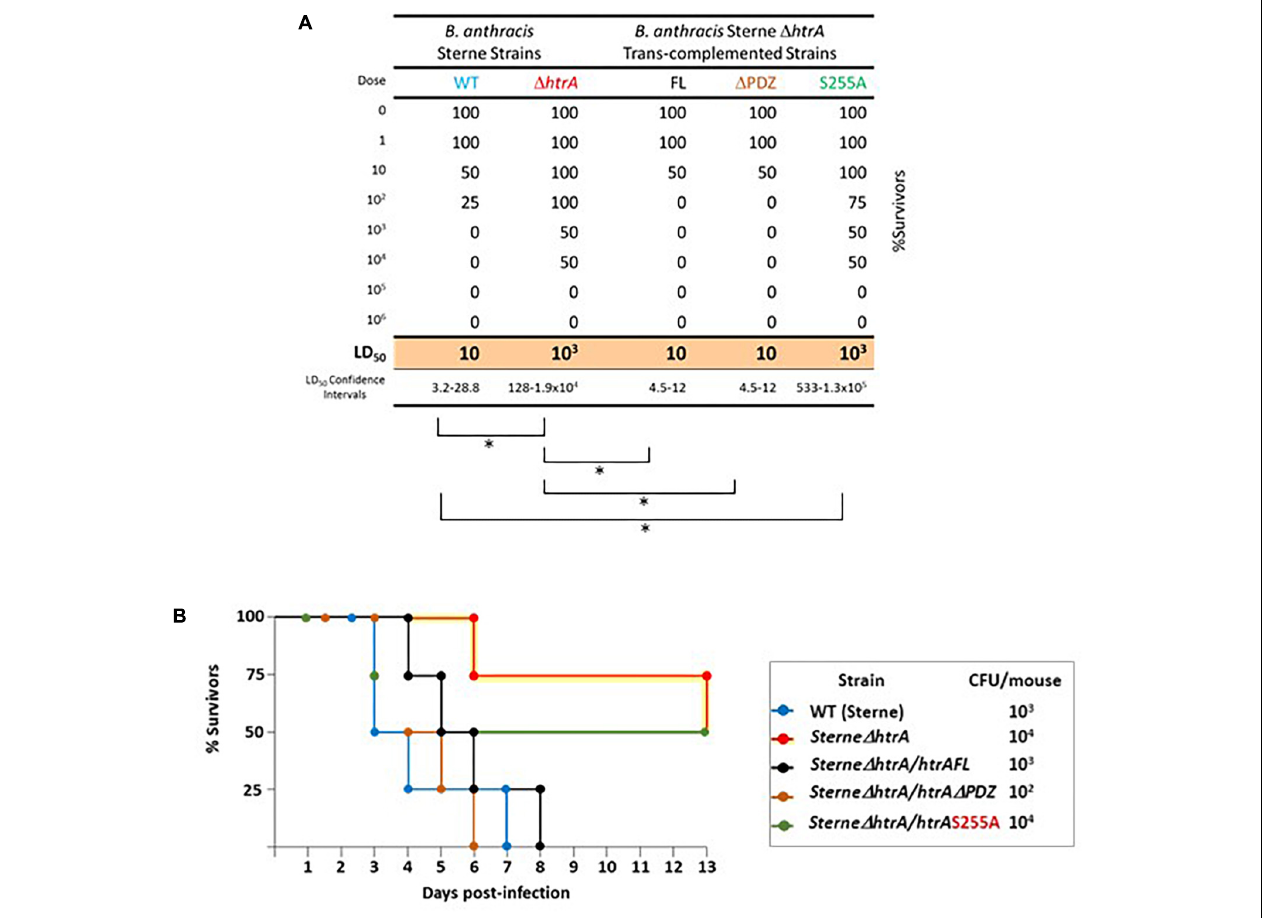
FIGURE 6 | Virulence of B. anthracis Sterne, S (cid:49) htrA, and the trans -complemented strains S (cid:49) htrA/HtrA, S (cid:49) htrA/HtrA (cid:49) PDZ, and S (cid:49) htrA/HtrA S255A, in a murine model of virulence assessment. (A) Survival table of mice infected by sub-cutaneous administration of the various strains. Each experimental group included 4 mice. The resulting Lethal Dose 50% (LD 50 ) and the 95% confidence intervals were calculated by global non-linear fit regression using the GraphPad Prism software. The statistical significance of the calculated LD 50 values was determined by the extra-sum-of-squares F comparison test using the GraphPad Prism software; ∗ p < 0.05. (B) Kaplan–Meier survival chart of selected experimental groups, as indicated in the boxed legend. Note that 10 4 bacteria of the S (cid:49) htrA or S (cid:49) htrA/HtrA S255A strains were administrated to mice, underlying the virulence attenuation of these strains; only 10 2 S (cid:49) htrA/HtrA (cid:49) PDZ bacteria were administered underlying the high virulence exhibited by the S (cid:49) htrA strain upon trans -complementation with the (cid:49) PDZ form of HtrA BA